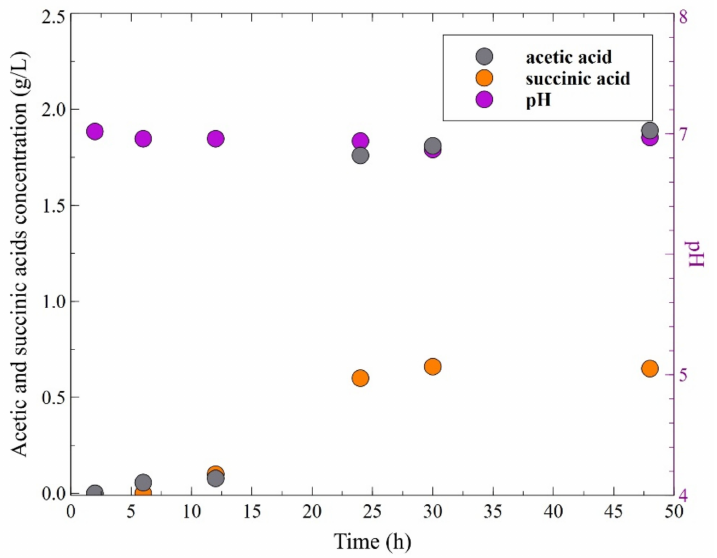
Figure 5. The changes of carboxylic acids concentrations and broth pH during the glycerol fermenta- tion process with pH regulation (broth pH = 7). Initial glycerol concentration: 20 g/L.